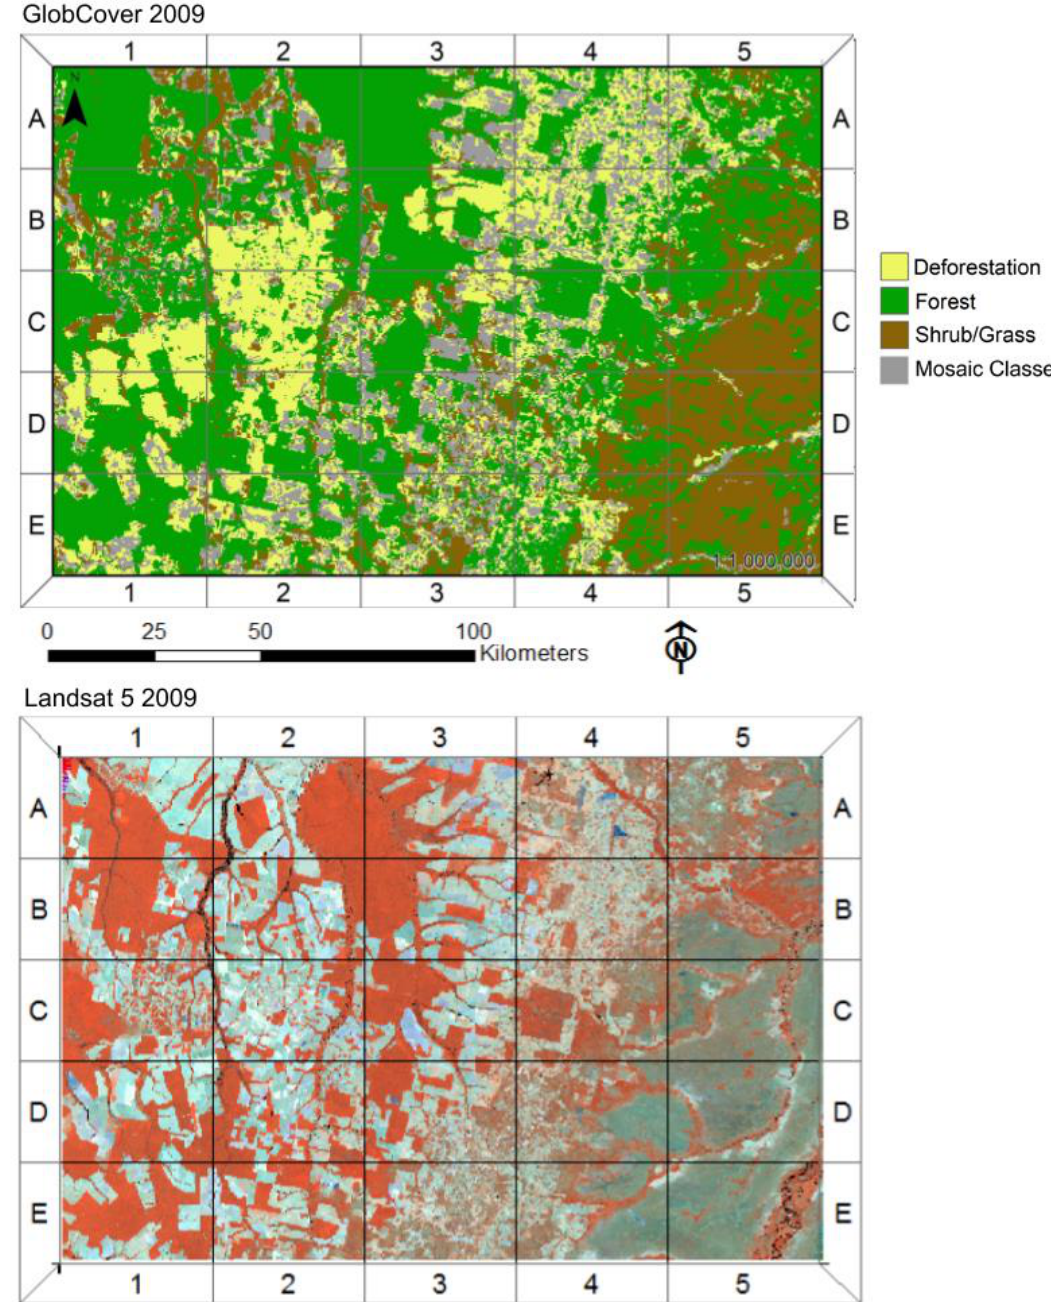
Figure 2. Base image used as a seed for the Bayesian Updating of Land Cover: Unsupervised method (BULC-U). GlobCover 2009 (above) and a Landsat 5 image from 2009 (below).